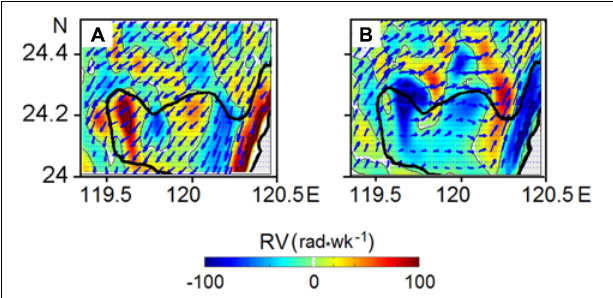
FIGURE 5 | The successive phases of the planar distribution of relative vorticity, RV (rad/week), above the CYR at a depth of 10 m (below the surface) corresponding to peak (A) flood and (B) ebb velocities, respectively. The black line delineates the 30 m isobaths.